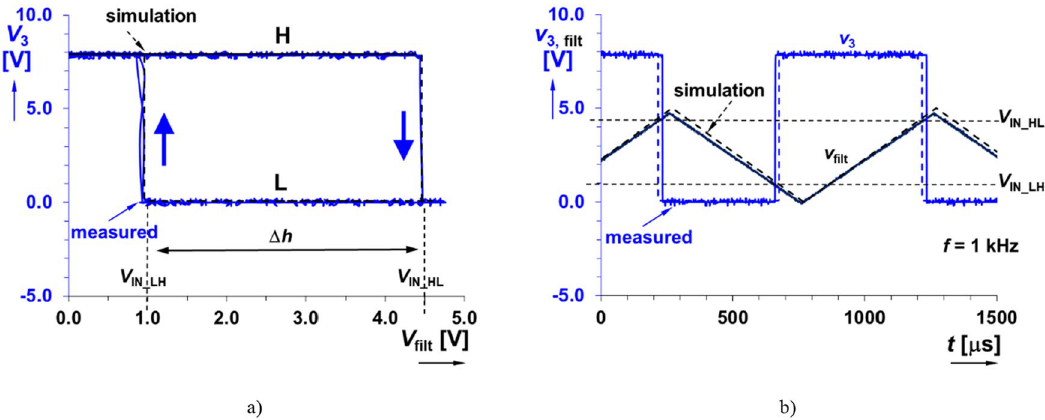
Figure 4. Test of the comparator stage in both simulation and measurement: ( a ) hysteresis diagram, ( b ) time-